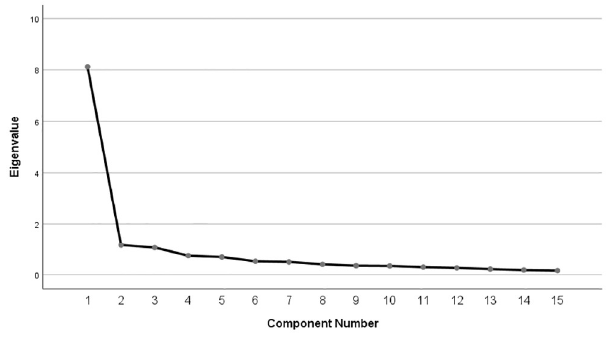
Fig 1. Scree plot for principal components analysis of the BIST.